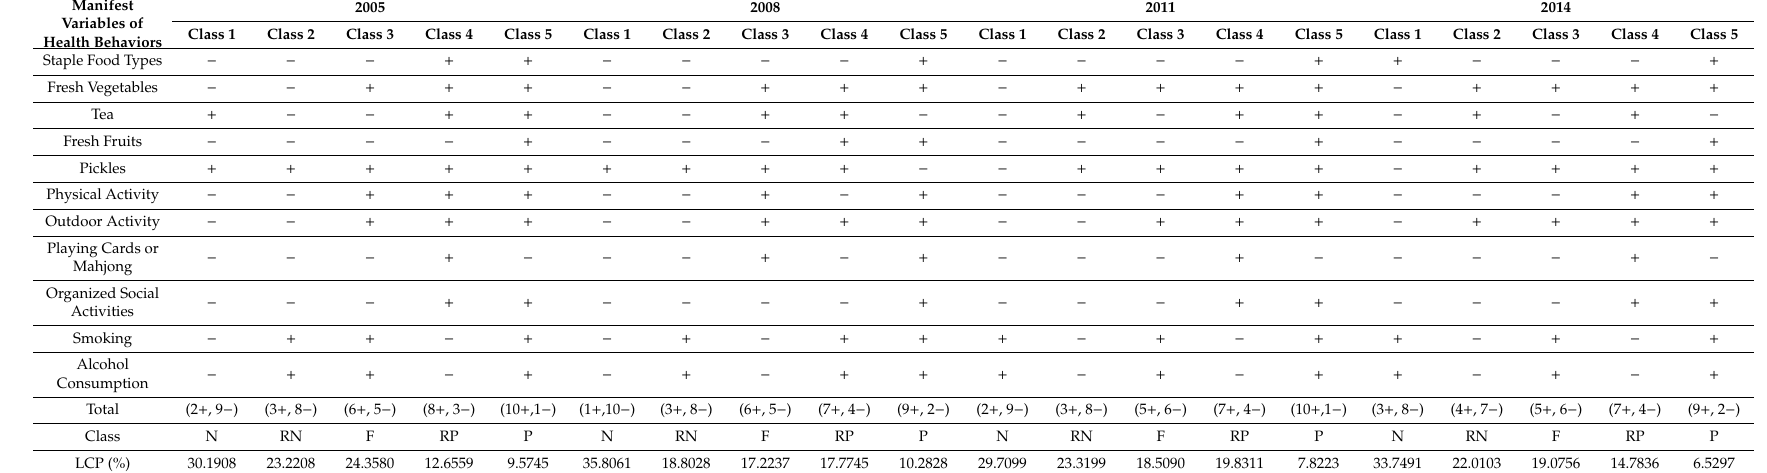
Table A1. Directions of each health behavior on elderly